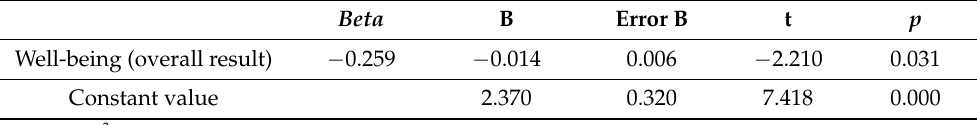
Table 7. PTSD predictors (individuals with no diagnosis) ( n = 70 in each group).